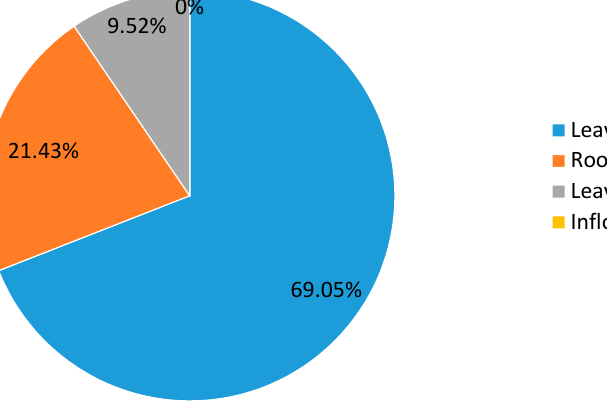
Figure 4. The used part of Salvia argentea .